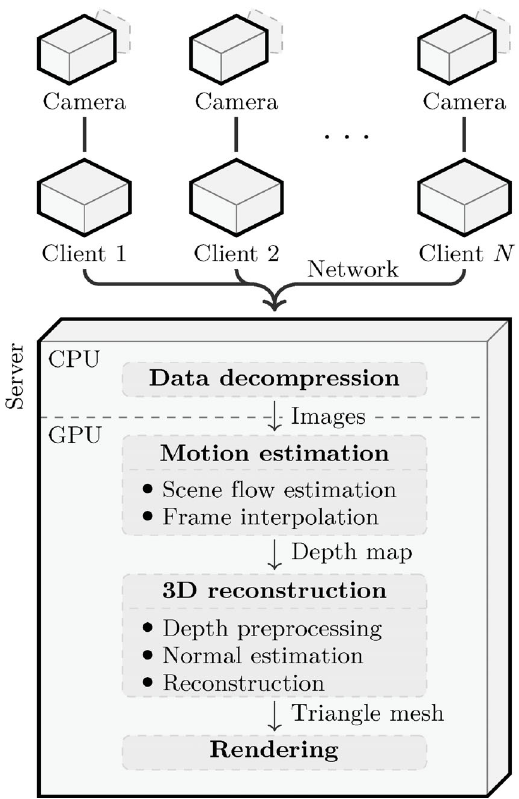
Fig. 1 FusionMLS